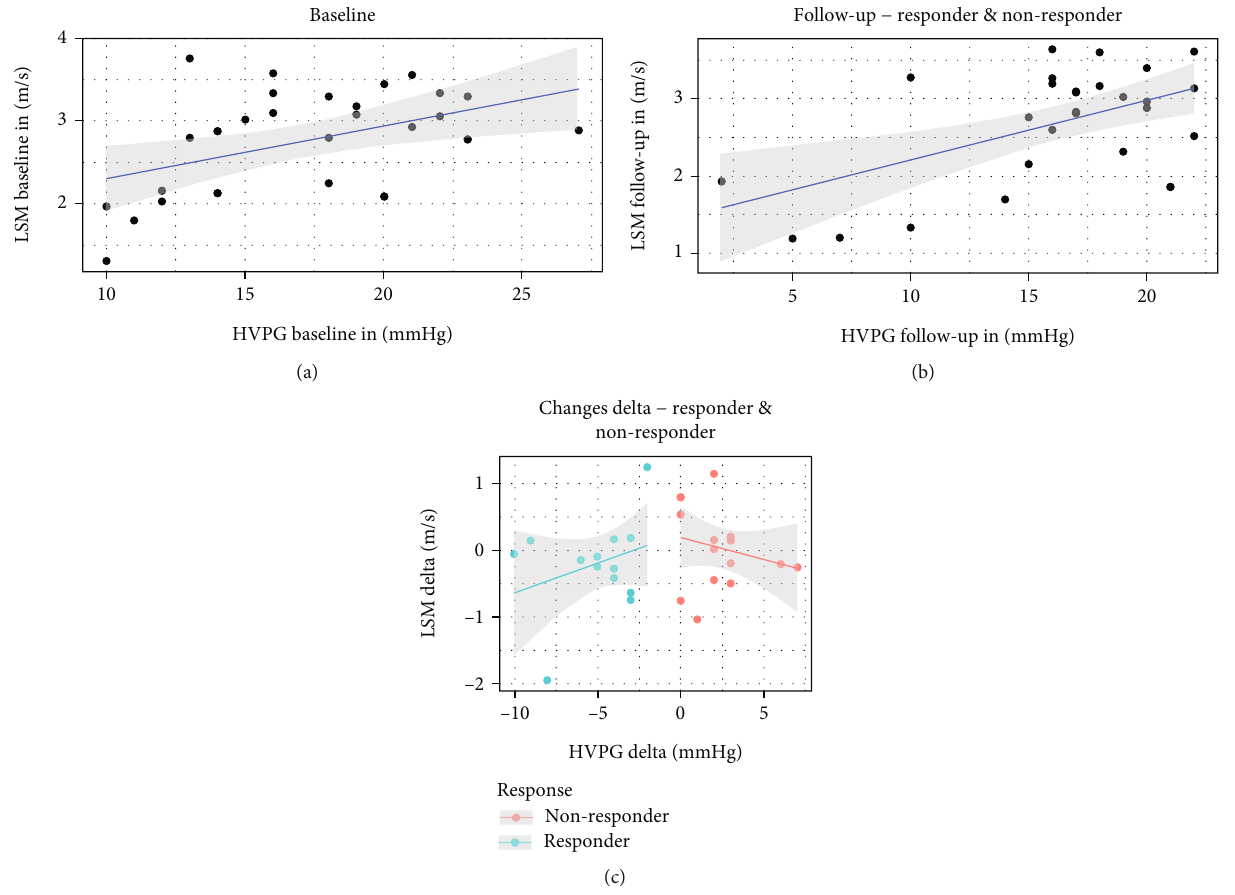
Figure 6: Results for liver elastography and corresponding HVPG results: LSM results showed a moderate/good correlation with corresponding HVPG results in both baseline (a) and follow-up investigations (b). Δ -HVPG and Δ -LSM values did not show any signi fi cant correlation both in response and non-response group (c) (HVPG =hepatic venous pressure gradient; SSM =spleen sti ff ness measurement; LSM=liver sti ff ness